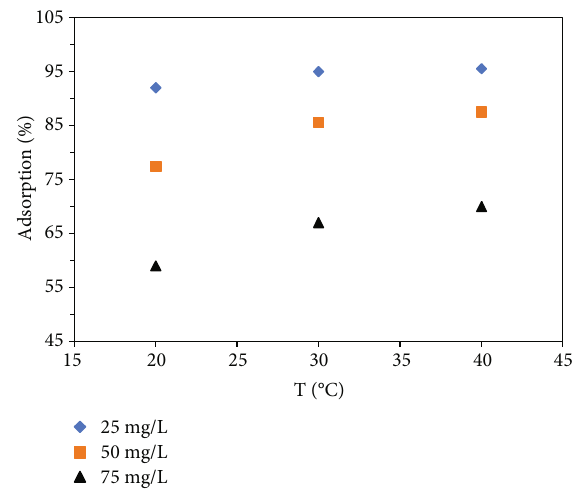
Figure 17: E ff ect of temperature variation on CV removal onto ACMAS ( sorbentdose = 0 : 15g/L , time = 120 min , and pH = 6 : 0 ).